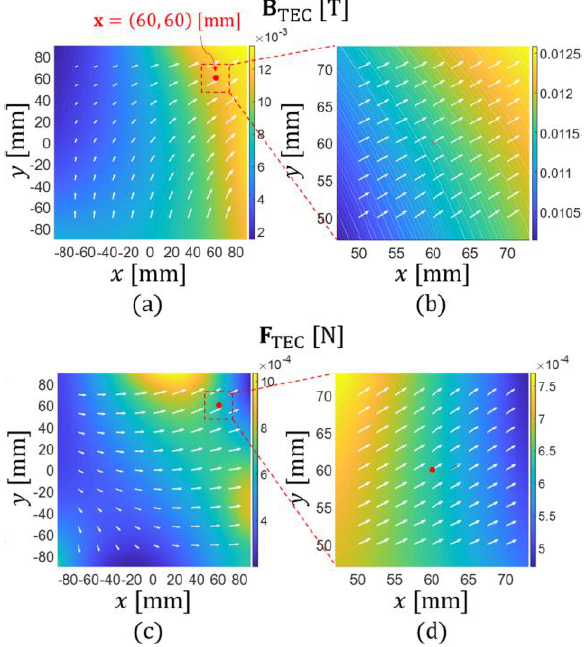
Figure 4. ( a , b ) Distribution of the magnetic field inside the TEC; ( c , d ) the corresponding magnetic force generated to apply a magnetic force of (𝐹 0 , 𝛼 𝐹 ) = (500 μN, 30°) to the microrobot located at 𝐱 = [60 mm,60 mm,0] T . In this case, the optimal 𝛼 𝐵 is approximately 39°.